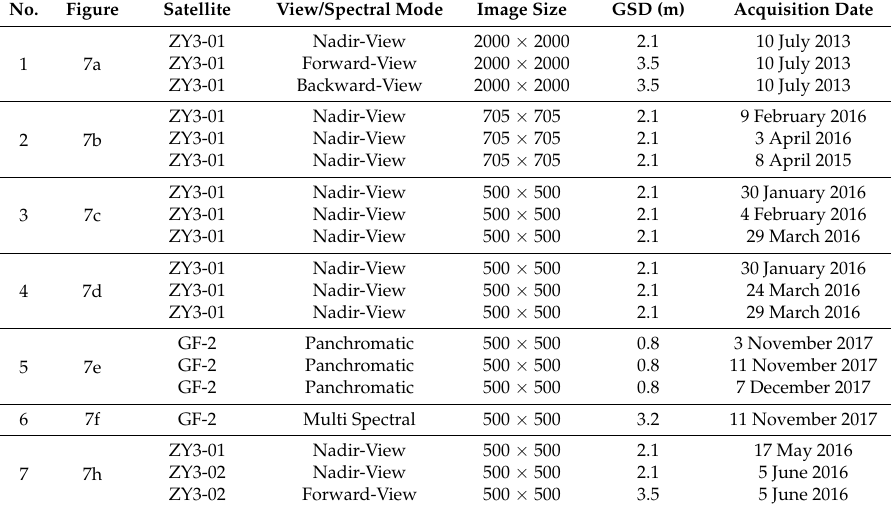
No. Figure Satellite Image